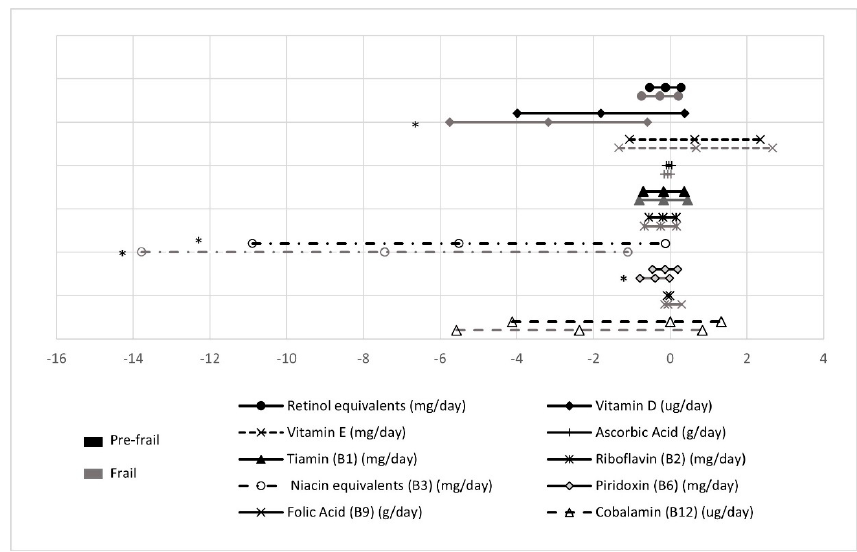
Figure 3. Vitamin intake in pre-frail and frail groups compared with robust (reference group). * Statistically significant differences ( p value < 0.05). For minerals (Figure 4), only pre-frail showed smaller intakes of phosphorus ( β =